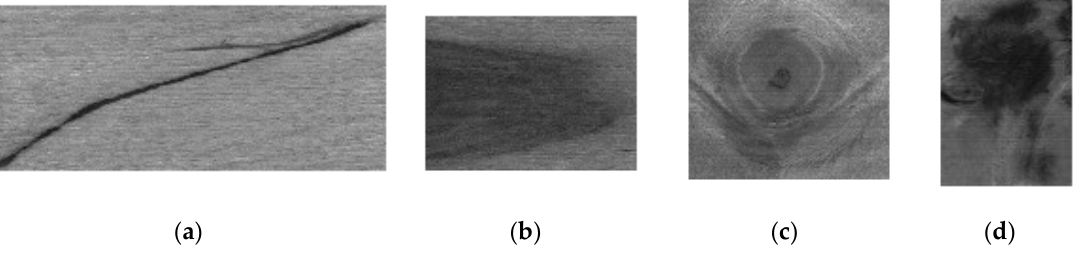
Figure 4. Examples of wood veneer defects: ( a ) split; ( b ) core; ( c ) branch; ( d ) stain.